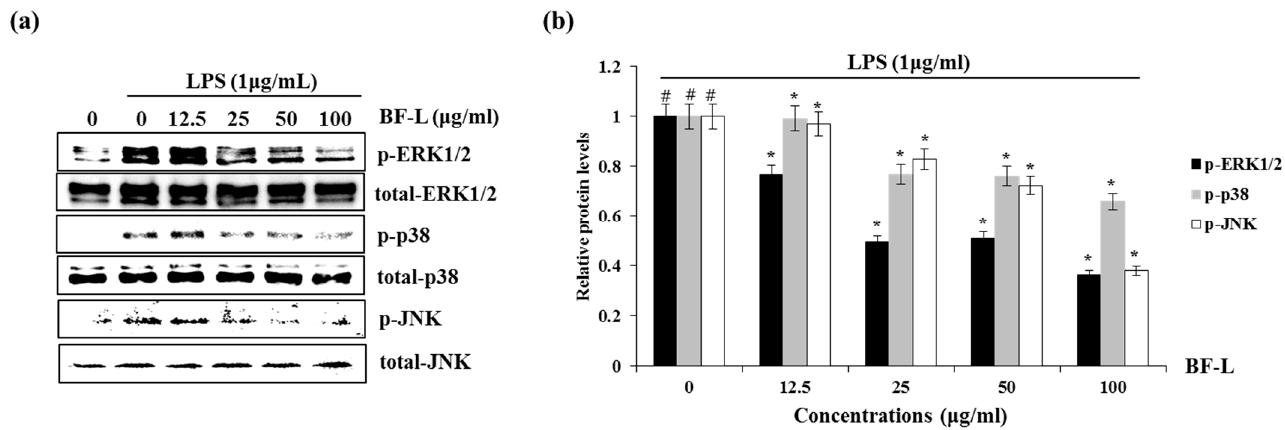
Figure 4. Effect of BF-L on MAPKssignaling activation in LPS-stimulated RAW264.7 cells. ( a ) and ( b ) RAW264.7 cells were pretreated with BF-L for 6 h and then co-treated with LPS (1 µ g/mL) for 30 min. For Western blot analysis, the cell lysates were subjected to SDS-PAGE and the Western blot was performed using antibodies against p-ERK1/2, p-p38, p-JNK, total ERK1/2, total p38 and total JNK. # p < 0.05 compared to the cells without BF-L, and * p < 0.05 compared to the cells treated with LPS alone.